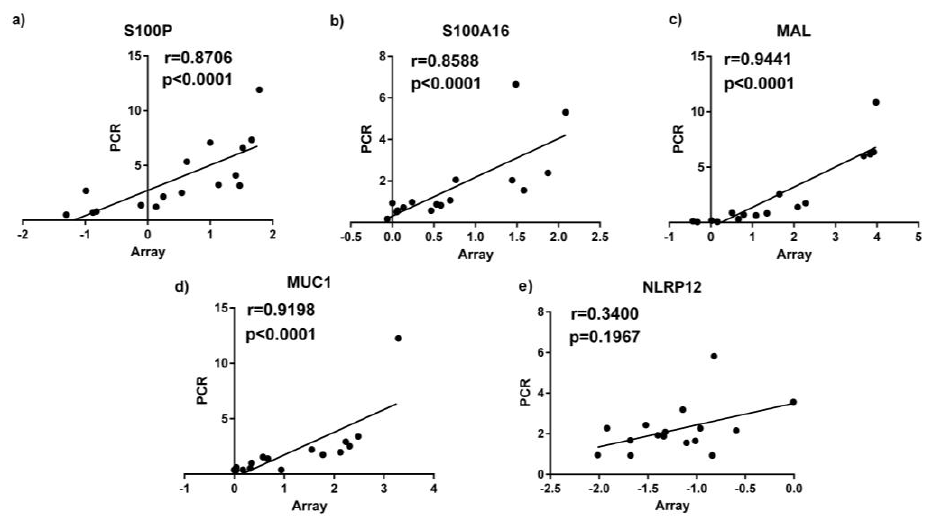
Figure 1. qPCR results correlated with microarray gene expression data (measured by qPCR) in sputum samples. ( a ) S100P; ( b ) S100A16; ( c ) MAL; ( d ) MUC1; ( e ) NLRP12.